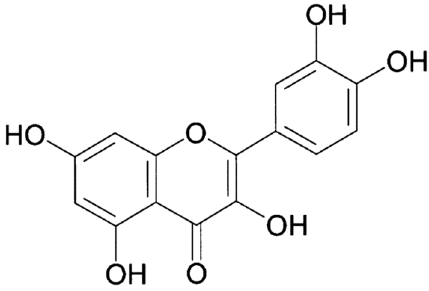
Fig. 1 Structure of quercetin (3,3 ′ ,4 ′